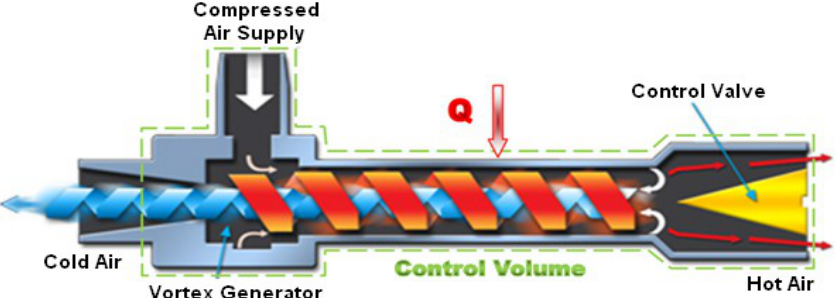
Figure 3. Vortex tube operation and control volume